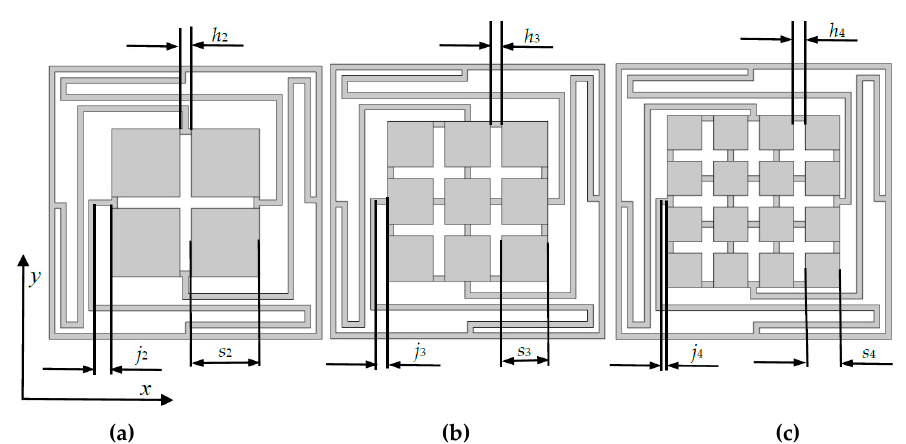
Figure 4. Three designed models for the multiple-scatter PC structures ( a – c